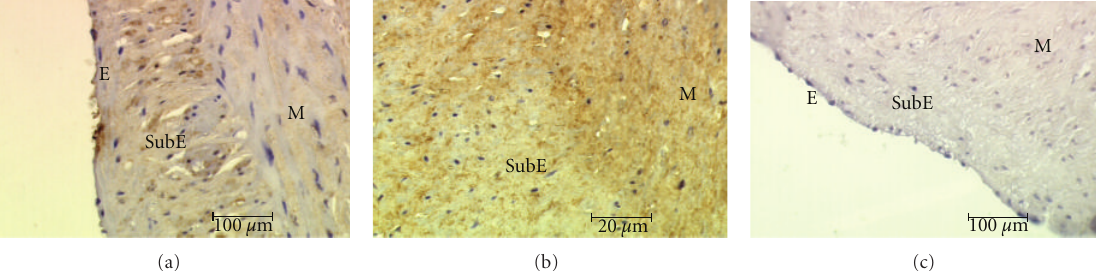
Figure 2: Expression of the NF-kappaB in the endothelium (E), subendothelial layer (SubE), and media (M). Group II (a) and Group III (b). (c) represents negative control (Group II).